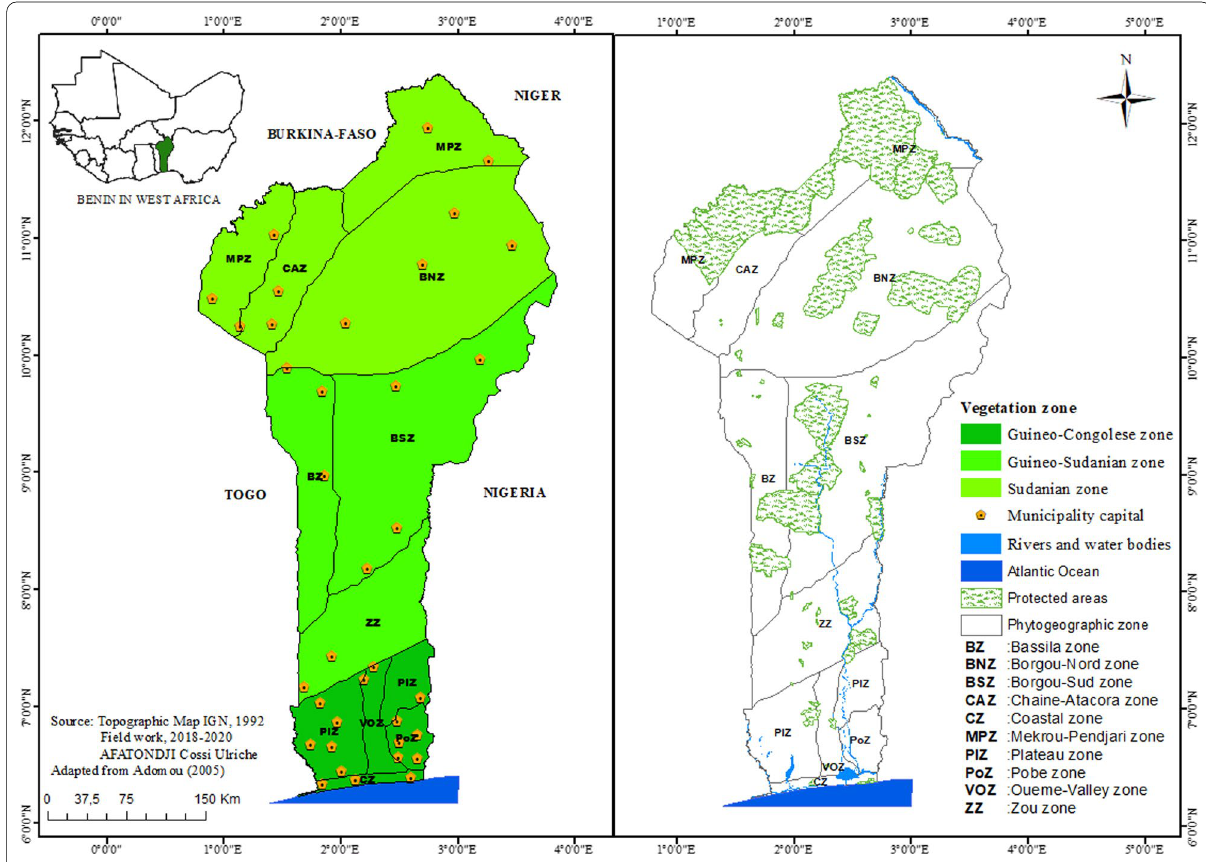
Fig. 1 Map of the vegetation zones and phytogeographic zones of Benin. Each orange dot shows a municipality sampled to assess the morphological variability and the distribution modeling of the goat population of Benin. The map was made using ArcGIS (ESRI